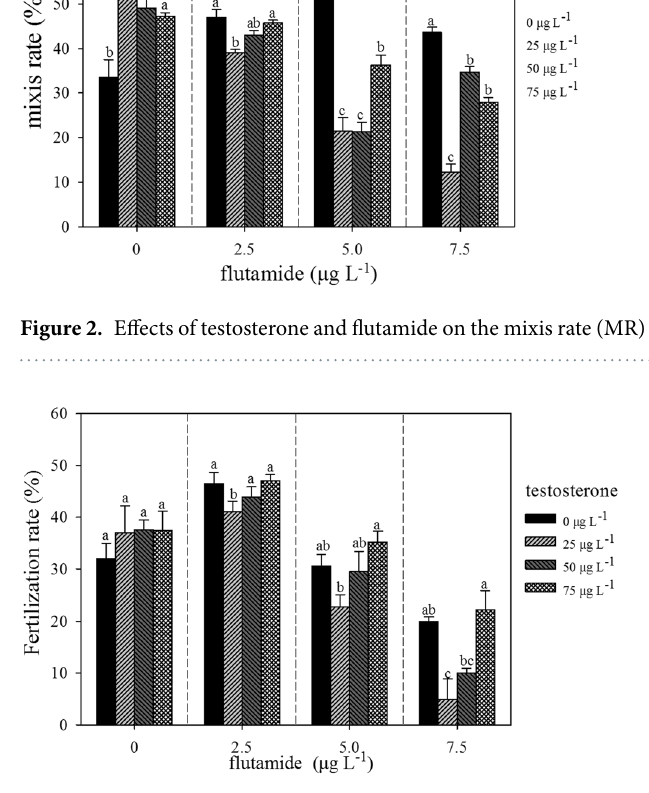
Figure 3. Effects of testosterone and flutamide on the fertilization rate in B. calyciflorus (n =